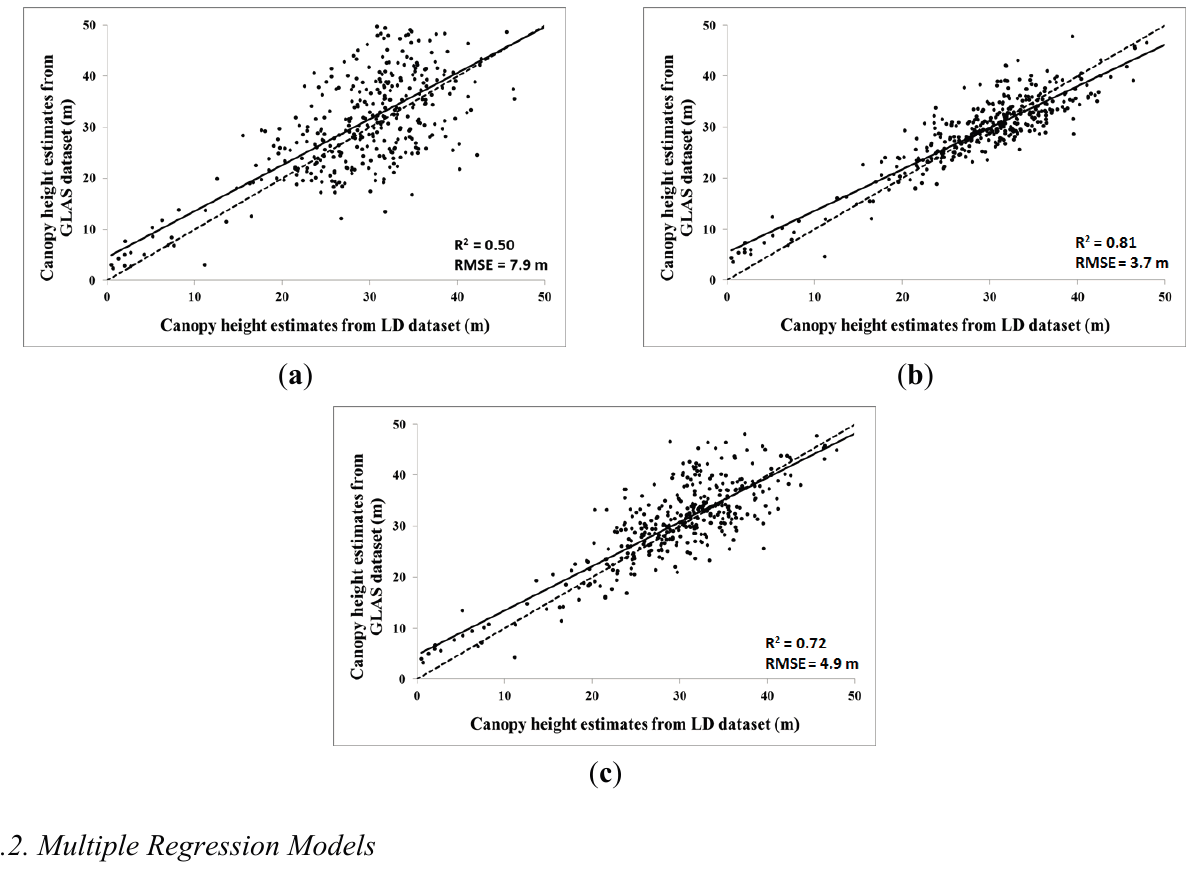
Figure 6. Canopy height estimates from GLAS data in comparison to estimated canopy heights from the LD dataset: ( a ) using the direct method (model ID 1, Table 2), ( b ) using the model with Wext, TI and Trail (model ID 7bis, Table 2), and ( c ) using the model with Wext and TI (model ID 2, Table